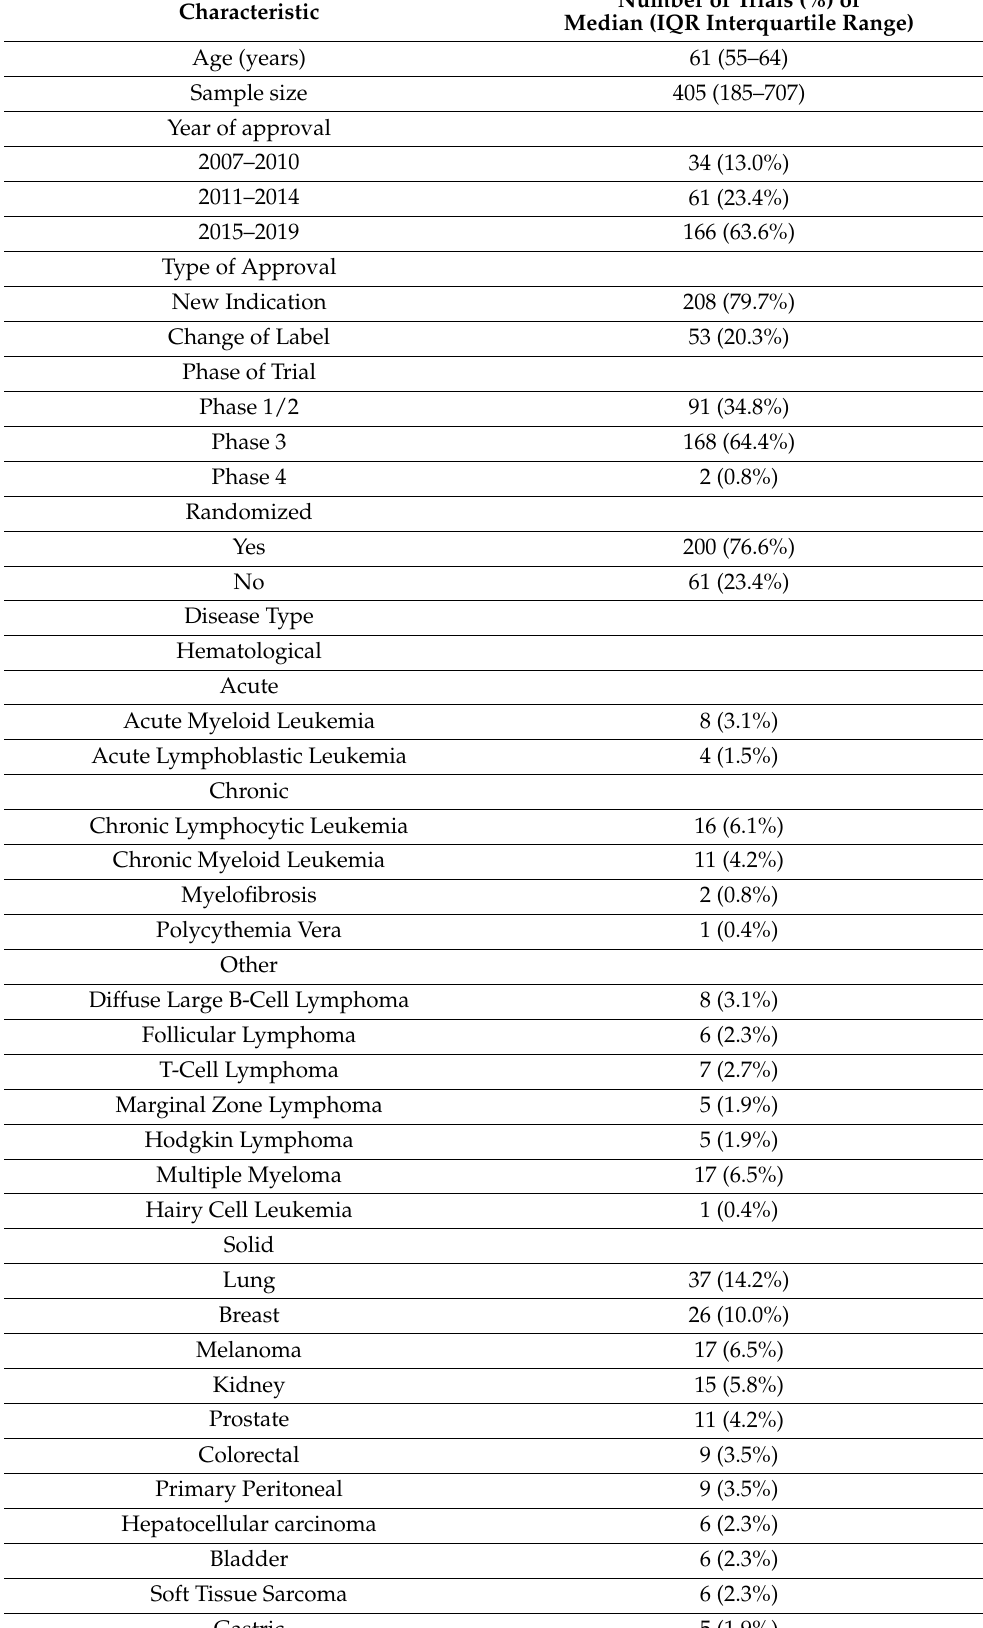
Table 1. Baseline characteristics of trials included in the